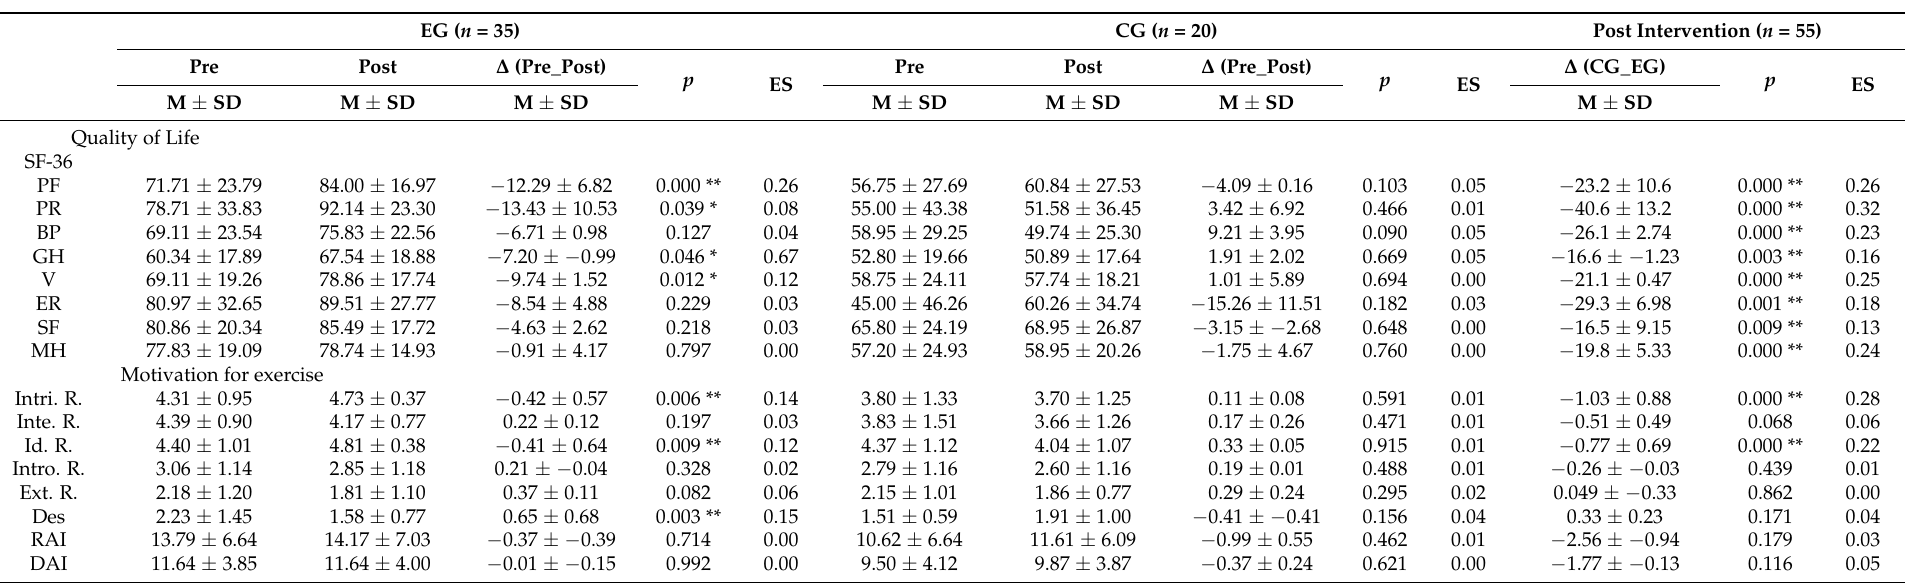
Table 4. Mean values obtained for quality of life and motivation for exercise before and after the MPTP in each of the groups.